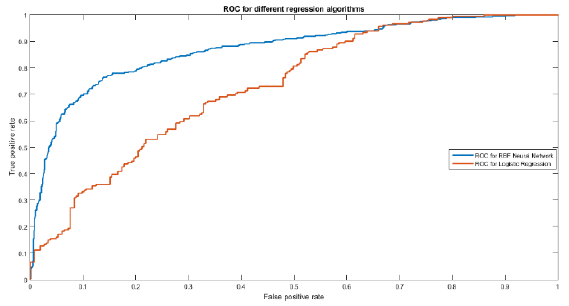
Figure 8. ROC curve to examine the accuracy of the methods